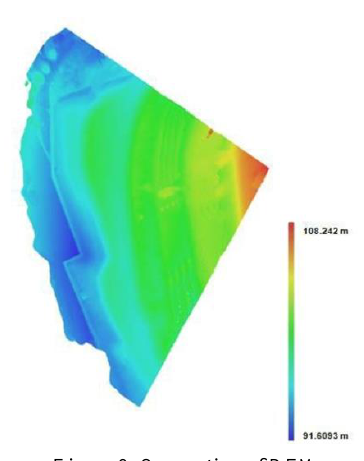
representation of the work under investigation, Figure